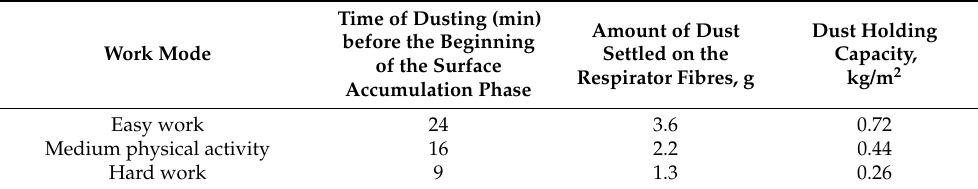
Table 3. Dust holding capacity of “Standart” respirators at various work modes with a dolomite dust concentration of 1000 mg/m 3 in the test chamber.